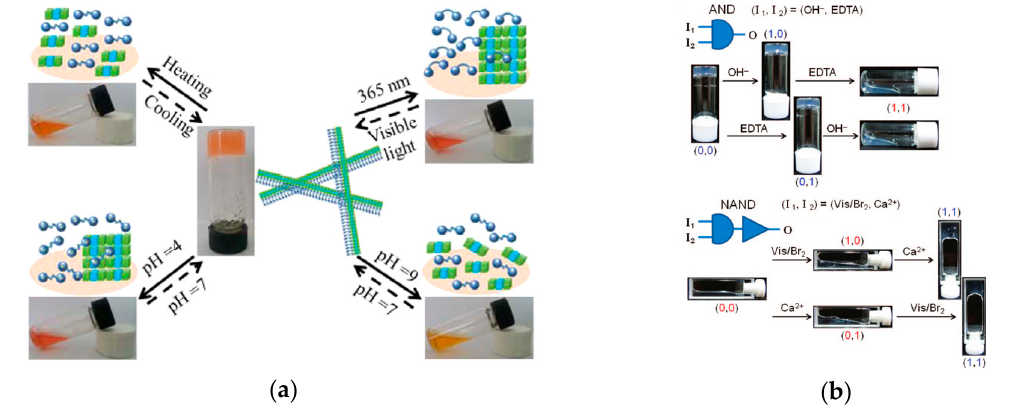
Figure 10. The ability to incorporate several sensitivities into supramolecular gels enables their use in logic-gate based drug delivery. ( a ) OR and XOR functionality in a supramolecular gel by Liu et al. [93]. Adapted with permission from ref [93]. Copyright 2015 American Chemical Society. ( b ) AND, OR, NAND, and NOR functionality in a supramolecular gel by Komatsu et al. [95]. Adapted with permission from ref [95]. Copyright 2009 American Chemical